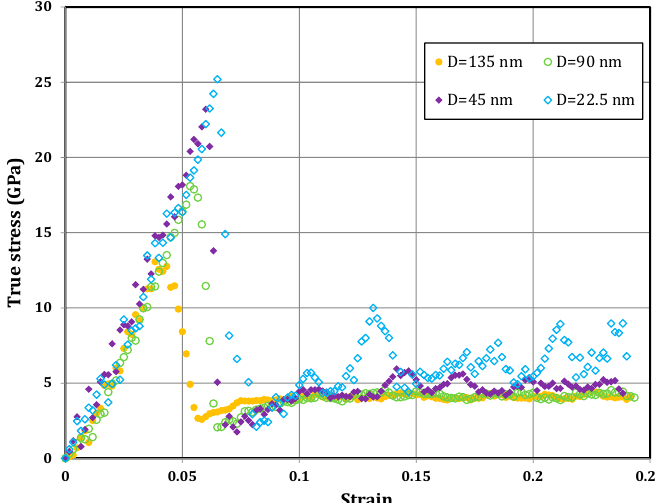
Figure 14. The responses of samples during micropillar compression test in the cases of pillars with H = 45 nm and different diameters of D = 22.5 nm, 45 nm, 90 nm, and 135 nm (after Yaghoobi and Voyiadjis [21]).